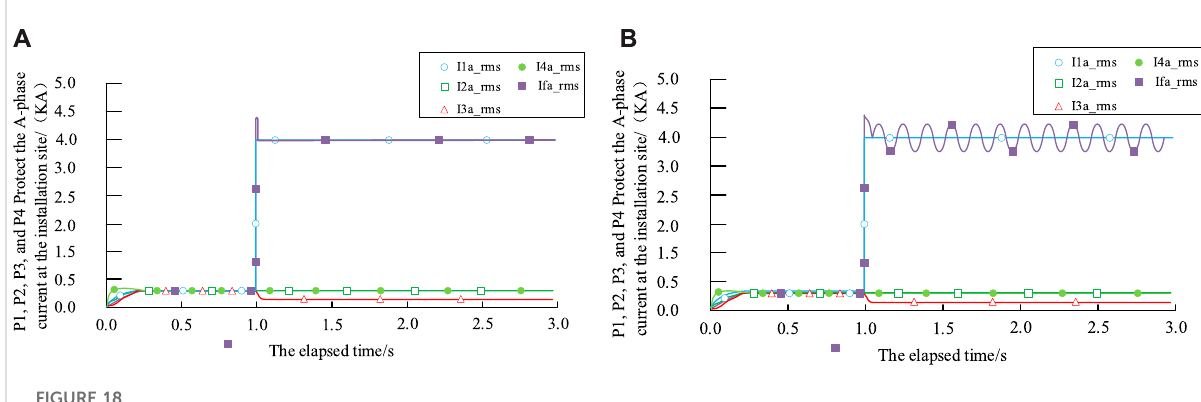
FIGURE 18 Current at each position of the AB terminal three-phase short-circuit fault. (A) Simulation results before DG access (B) Simulation results after DG access.